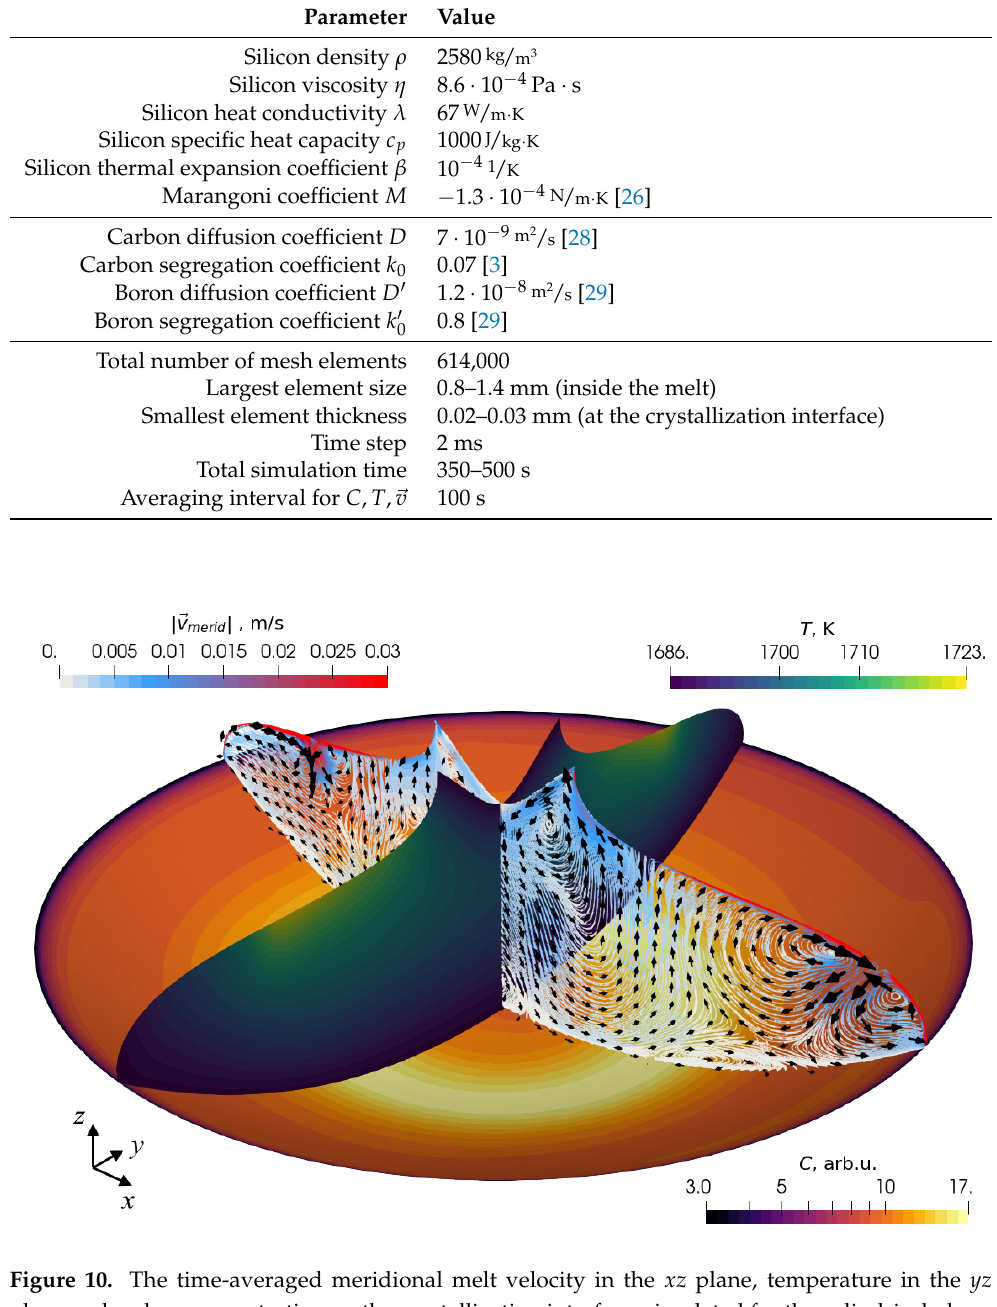
Table 2. The physical [27] and numerical parameters that were used for OpenFOAM simulations.